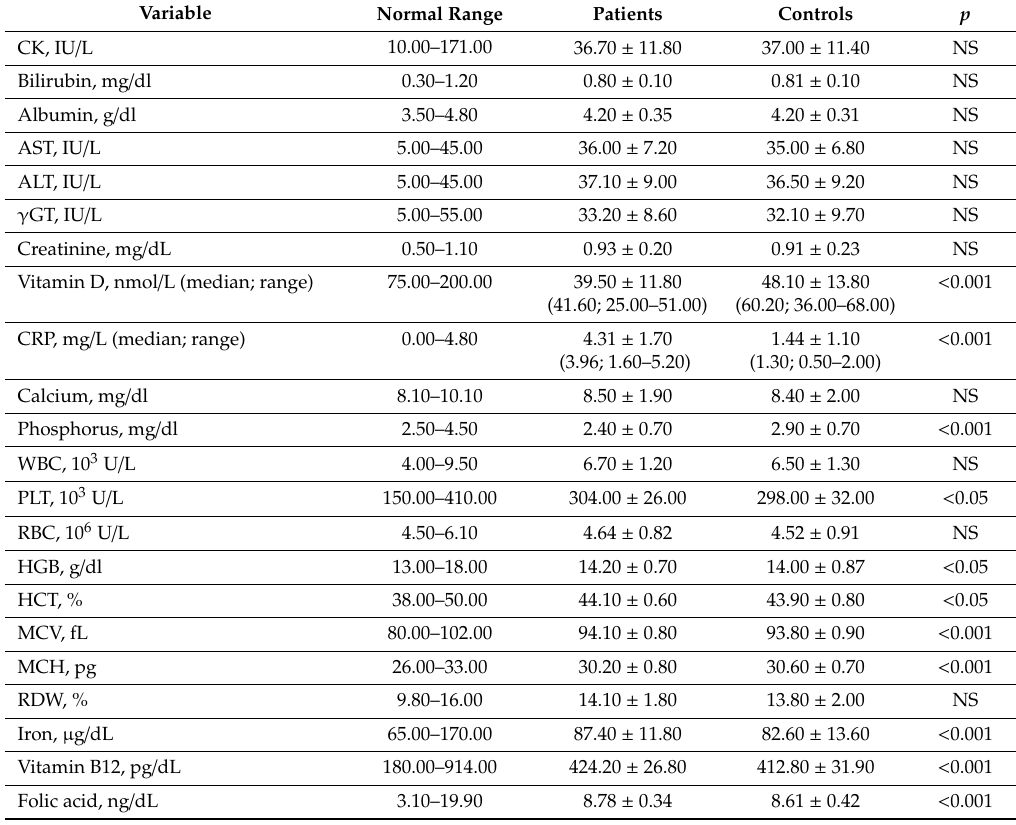
Table 2. Laboratory measurement on patients’ sera.